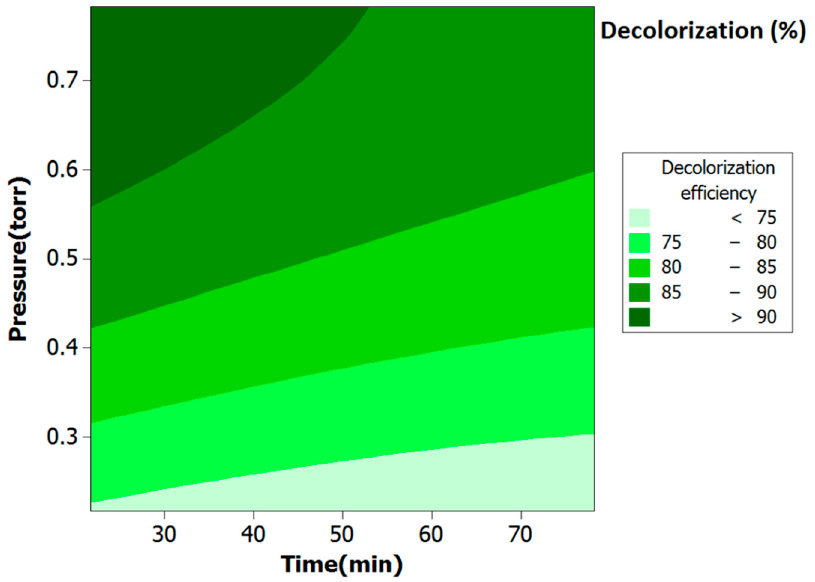
Figure 7. Response surface of MG decolorization as a function of plasma exposure time and pressure.